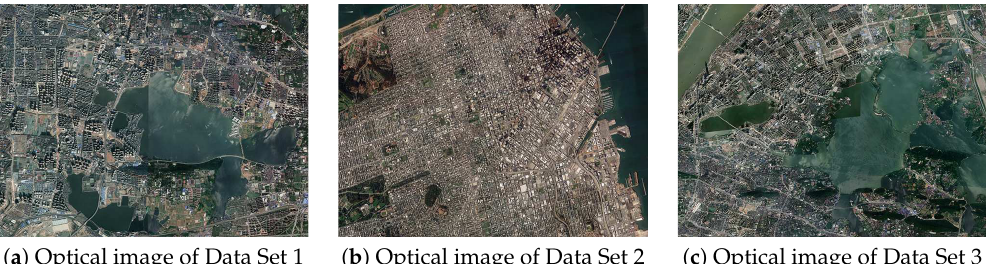
Figure 9. Optical images of the three experimental Data Sets.